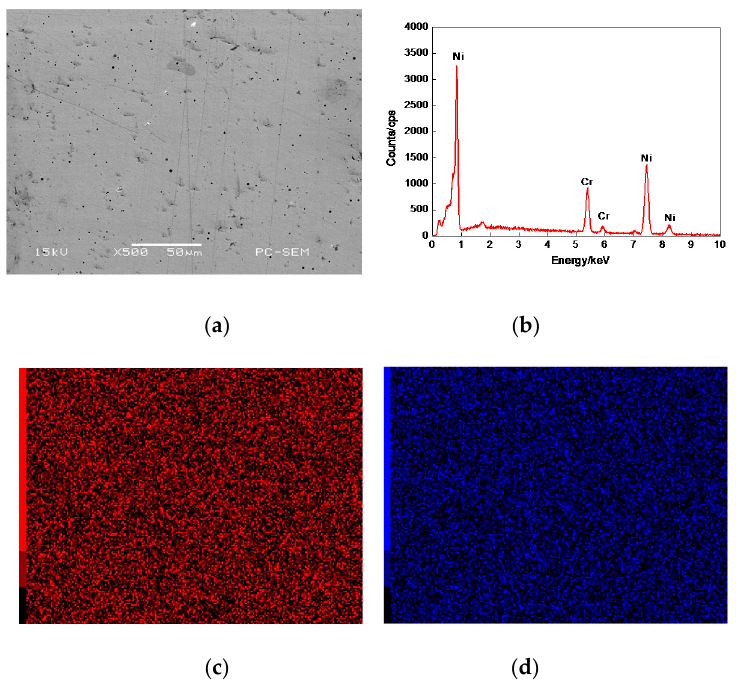
Figure 3. Plane scan analysis of 17% Cr–83% Ni coating surface. ( a ) Plane scanned position; ( b ) Plane scan analysis 17% Cr–83% Ni coating; ( c ) Distribution of Cr content; ( d ) Distribution of Ni content.